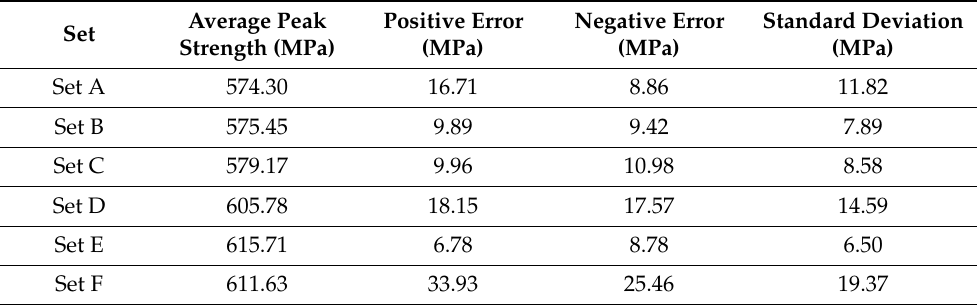
Table 6. Average peak strength values (MPa) for all six sets showing standard deviation.